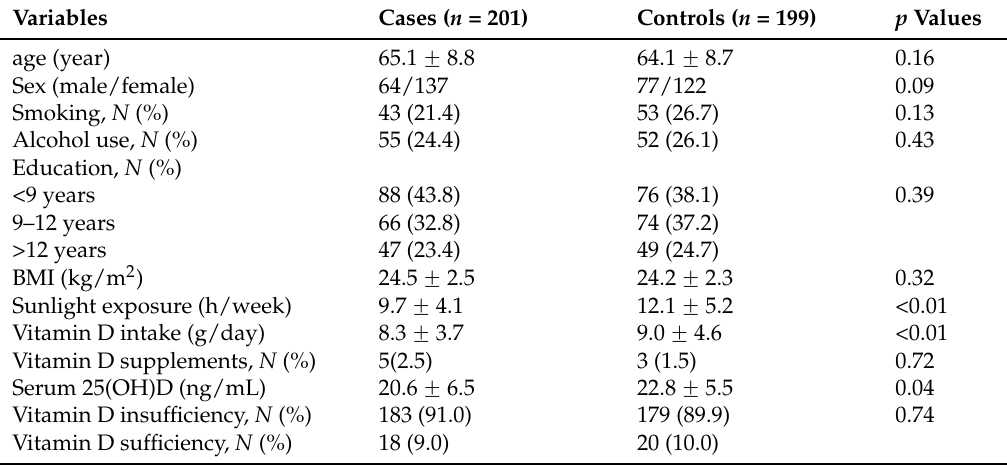
Table 1. Demographic and clinical characteristics of the participants in this study.